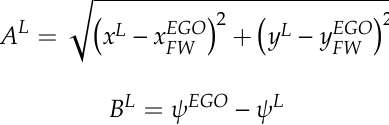
Figure 5. Perceptible and imperceptible points with impact area.